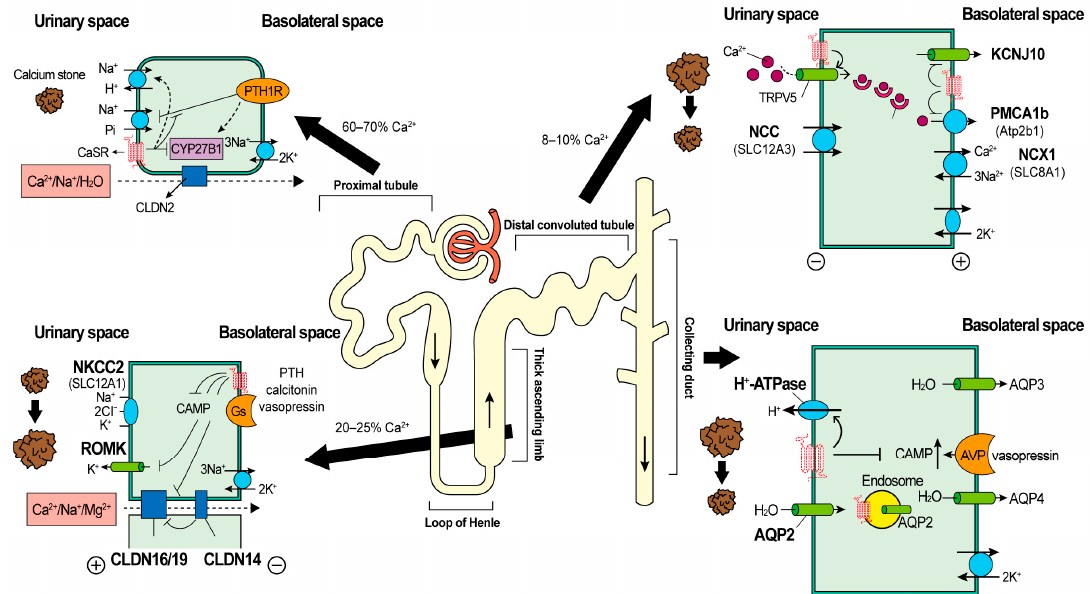
Figure 1. After glomerulus filtration, urinary Ca 2+ flows through the proximal tubule (PT), with 60–70% reabsorption occurring via the paracellular routes. The calcium-sensing receptor (CaSR) is mainly expressed on the basolateral membrane of PT. The major role of the CaSR in the PT is to counteract parathyroid hormone (PTH)-mediated Pi excretion, leading to reduced phosphaturia. Claudin 2 (CLDN2) is a novel paracellular cation channel, and that it is permeable to Ca 2+ and Na + . After the PT, urine passes to the thick ascending limb of the loop of Henle (TAL), which has the highest expression of CaSR and causes 20–25% Ca 2+ reabsorption via the paracellular routes. When hypercalcemia activates CaSR in the TAL, it leads to the inhibition of renal-outer-medullary-potassium (ROMK), which prevents apical K + recycling—the rate-limiting step for Na + -K + -Cl − cotransporter 2 (NKCC2) activity and reduces intracellular cyclic AMP (cAMP) levels. This effect leads to a loss of the driving force for paracellular Ca 2+ reabsorption. The activation of CaSR can also enhance CLDN14, which is responsible for controlling Ca 2+ influx. Through the segment of the distal convoluted tubule (DCT), 8–10% Ca 2+ will be reabsorbed via the transcellular routes. Transient receptor potential cation channel subfamily V member 5 (TRPV5), activated by CaSR, is the key channel to reuptake Ca 2+ . Plasma membrane calcium ATPase 1b (PMCA1b) and the calcium/sodium exchanger (NCX1) are the Ca 2+ channels located basolaterally and are mediated by CaSR. Finally, in the collecting duct, apical CaSR activation reduces vasopressin-mediated apical insertion of the aquaporin 2 (AQP2) water channel and decreases the water reabsorption. In addition, CaSR activation could also inhibit H + -ATPase and lead to urinary acidification. PT, proximal tubule; CaSR, calcium-sensing receptor; PTH, parathyroid hormone; Pi, phosphate; CLDN, claudin; TAL, thick ascending limb of the loop of Henle; DCT, distal convoluted